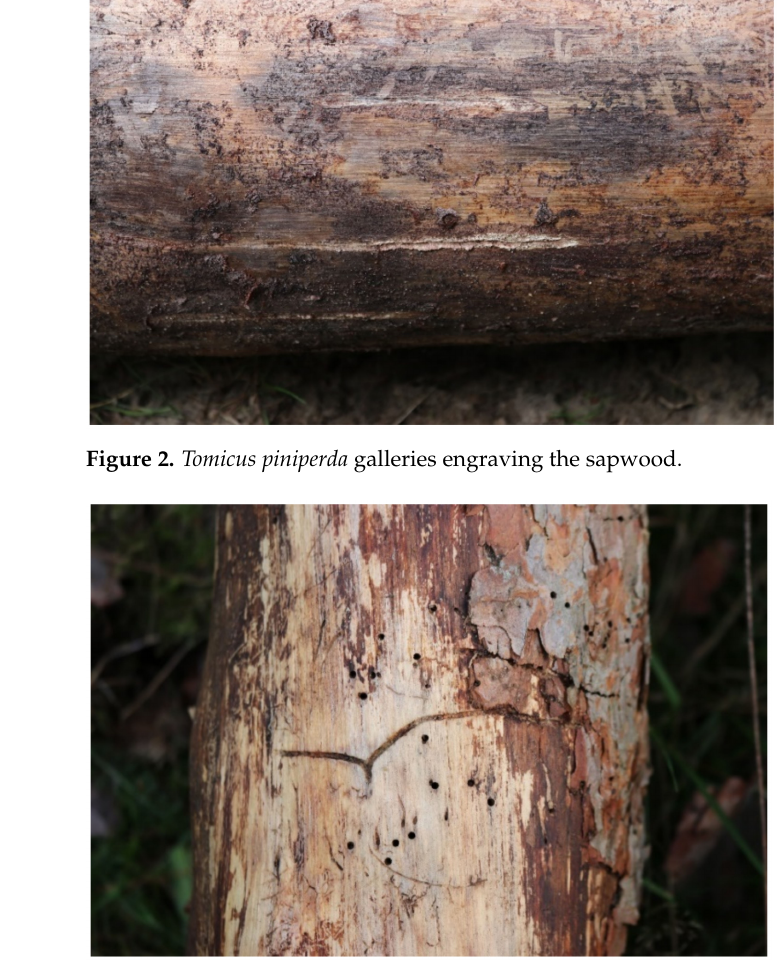
Figure 3. Tomicus minor gallery with bark showing exit